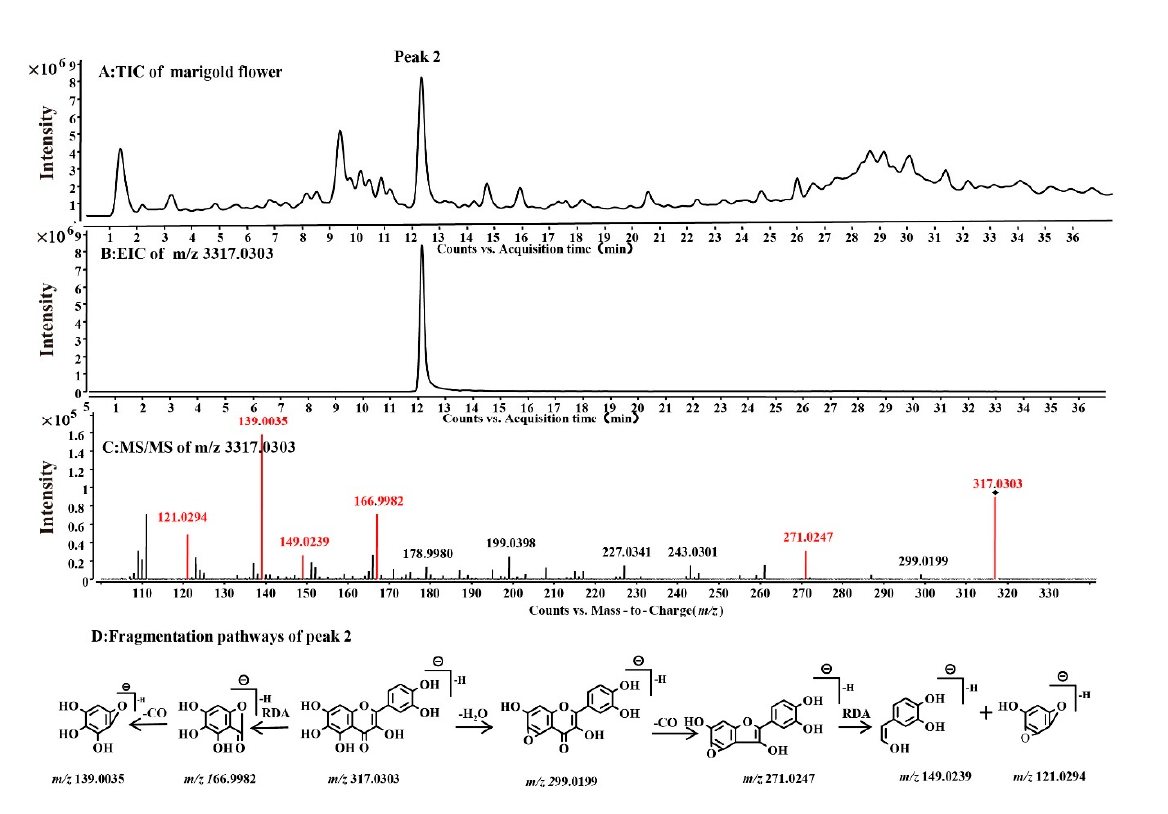
Figure 2. Screening of compound 2 by accurate-target means in the TIC ( A ), EIC ( B ) and MS/MS spectra ( C ) and the fragmentation pathway of compound 2 in the methanol extract of marigold flower ( D ). Table 2. Identified potential antioxidant compounds of the methanol extract of marigold. Peak No.